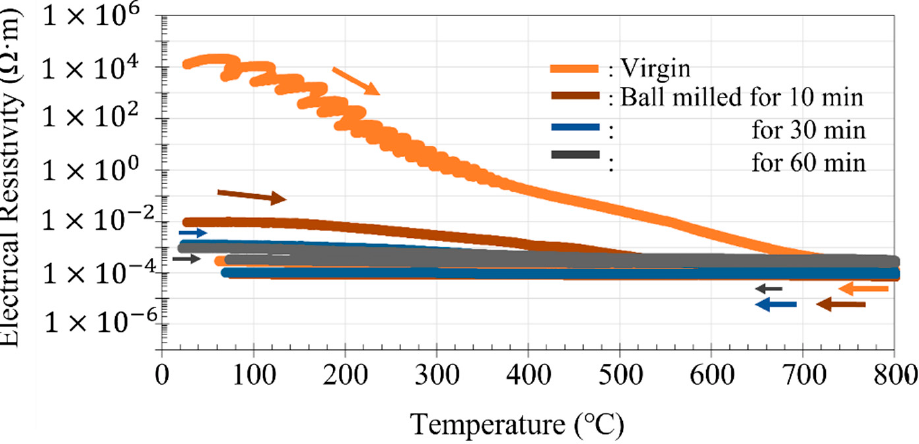
Figure 10. Change in direct current (DC) electrical resistivity of virgin and ball-milled (10, 30, and 60 min) Inconel 718 PA powder during heating ( → ) and cooling ( ← ) between room temperature (23 °C) and 800 °C.